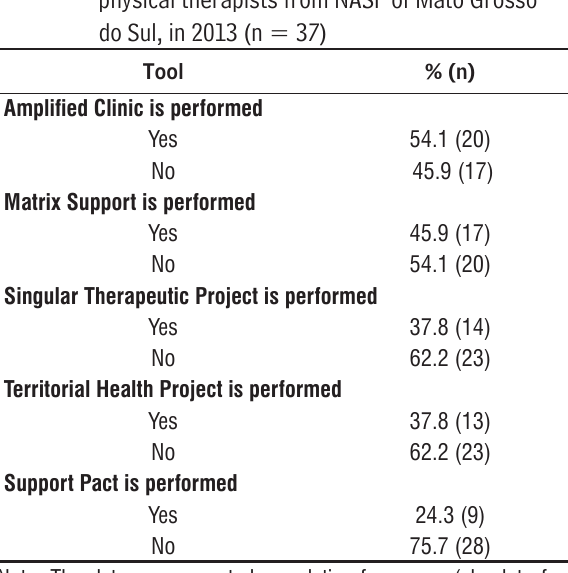
Table 4 - Use of tools inherent to NASF carried out by physical therapists from NASF of Mato Grosso do Sul, in 2013 (n =